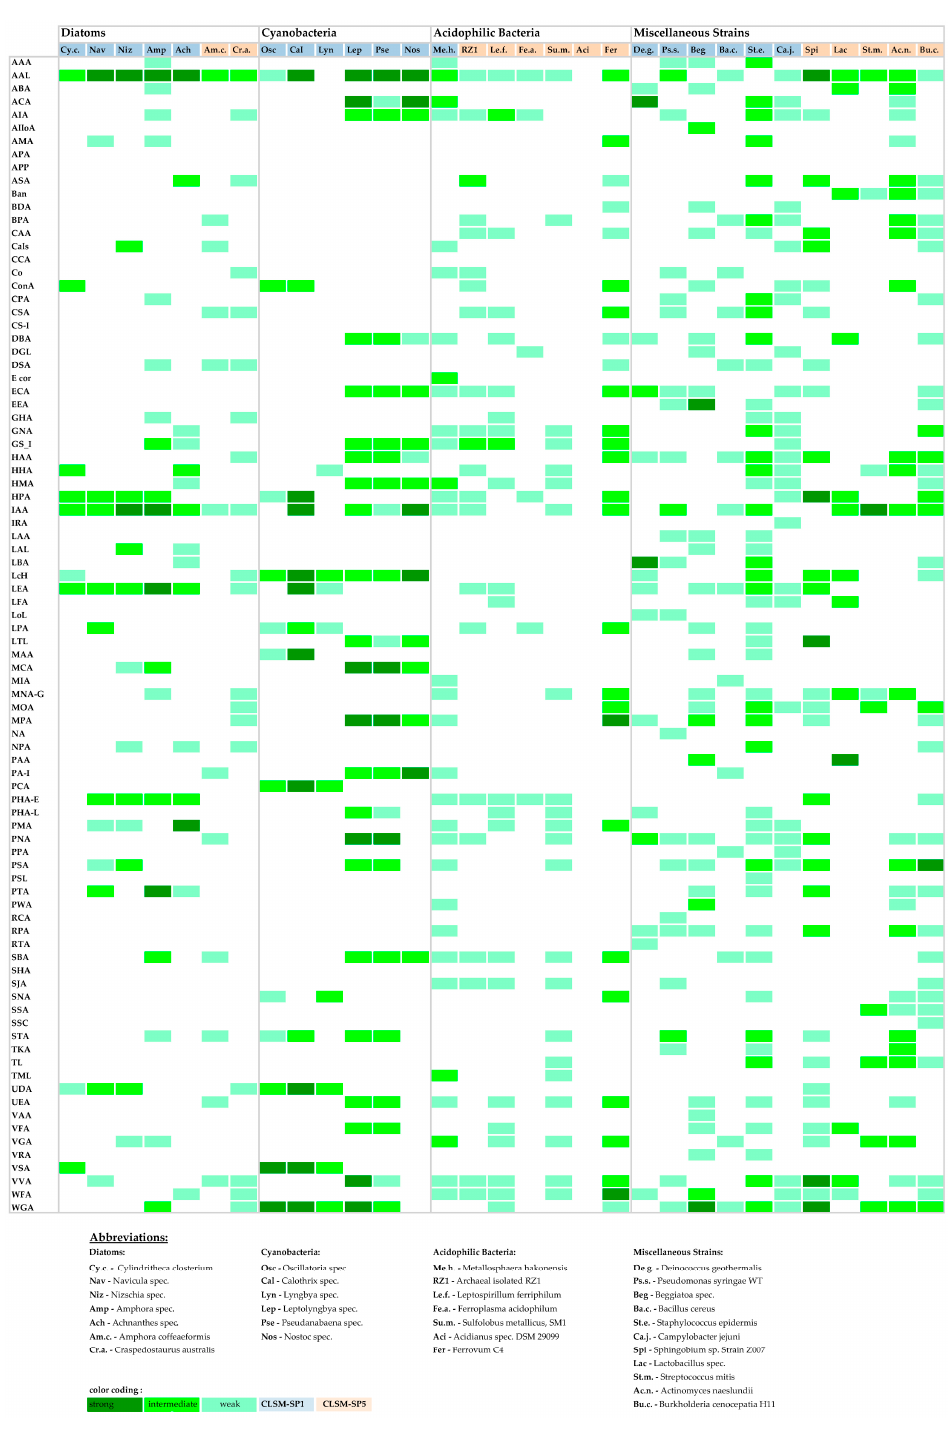
Figure 1. Fluorescence lectin bar-coding (FLBC) derived from confocal laser scanning microscopy and presented as heat map bar-coding pattern.